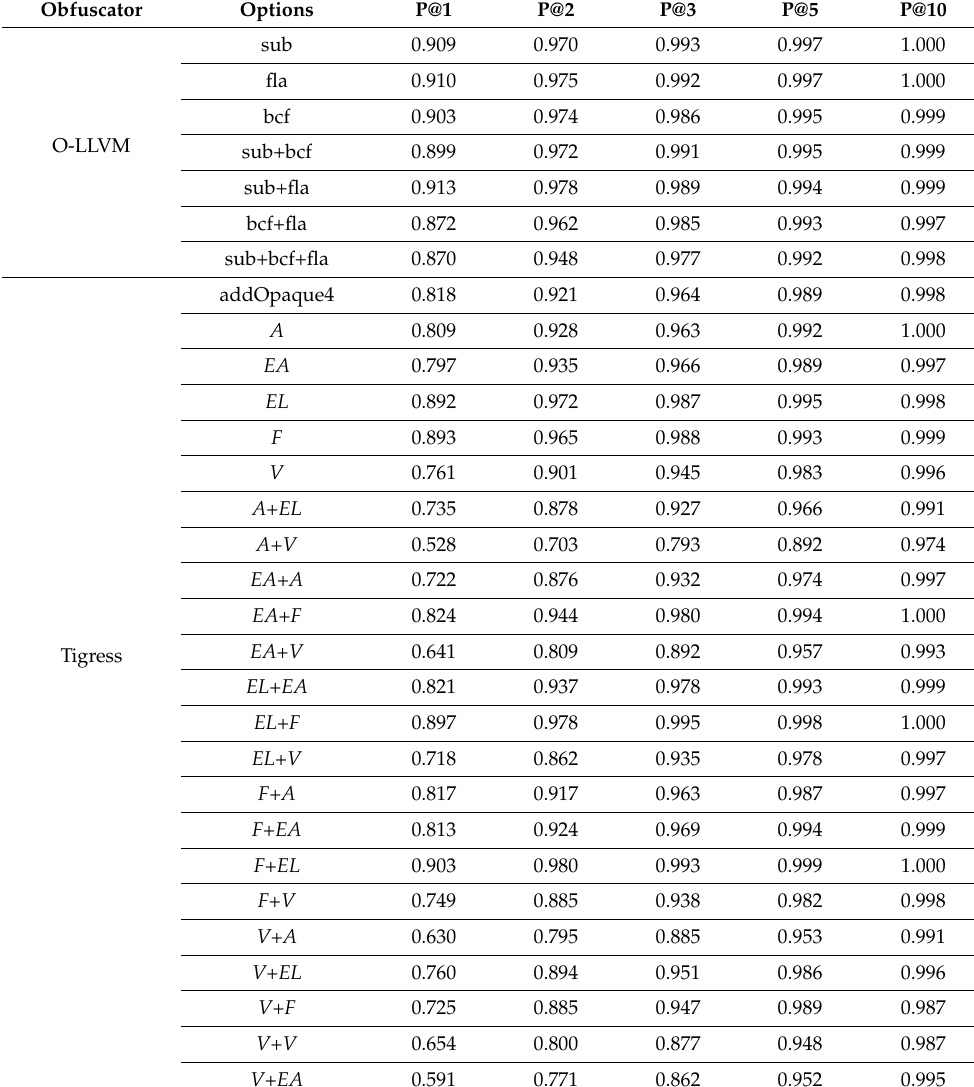
Table 3. Experimental results of obfuscated code similarity detection. Obfuscator